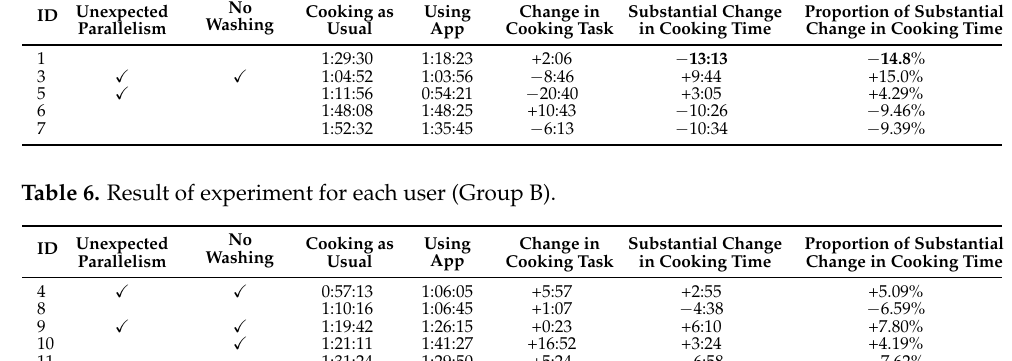
Table 5. Result of experiment for each user (Group A).